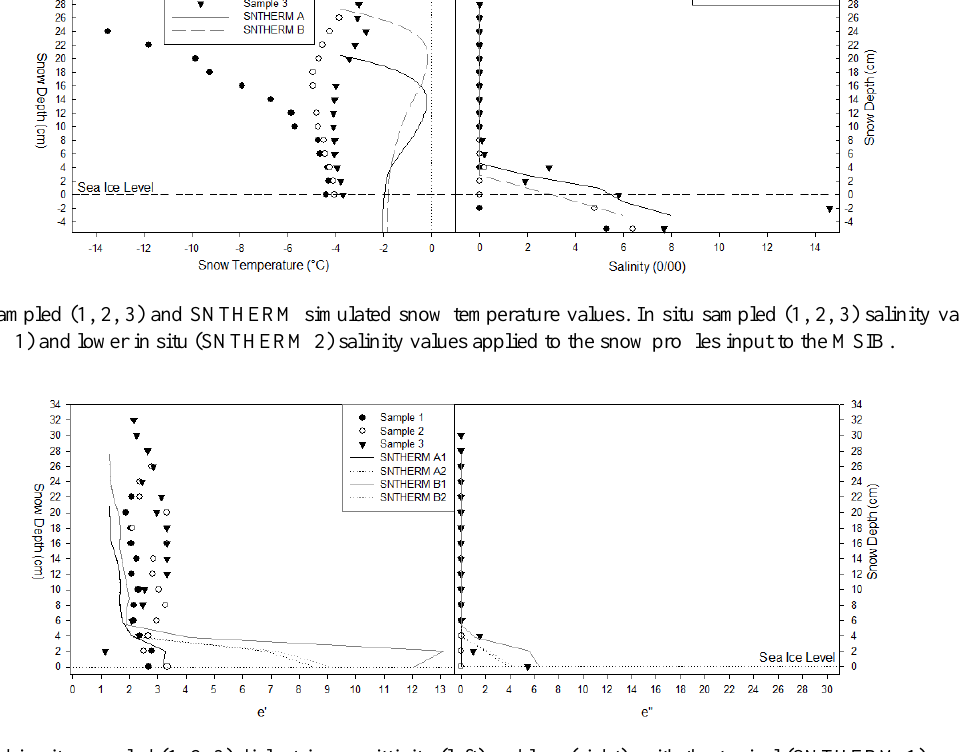
Figure 10. Modeled in situ sampled (1, 2, 3) dielectric permittivity (left) and loss (right), with the typical (SNTHERM 1) and lower in situ (SNTHERM 2) salinity values applied to the SNTHERM snow profiles input to the